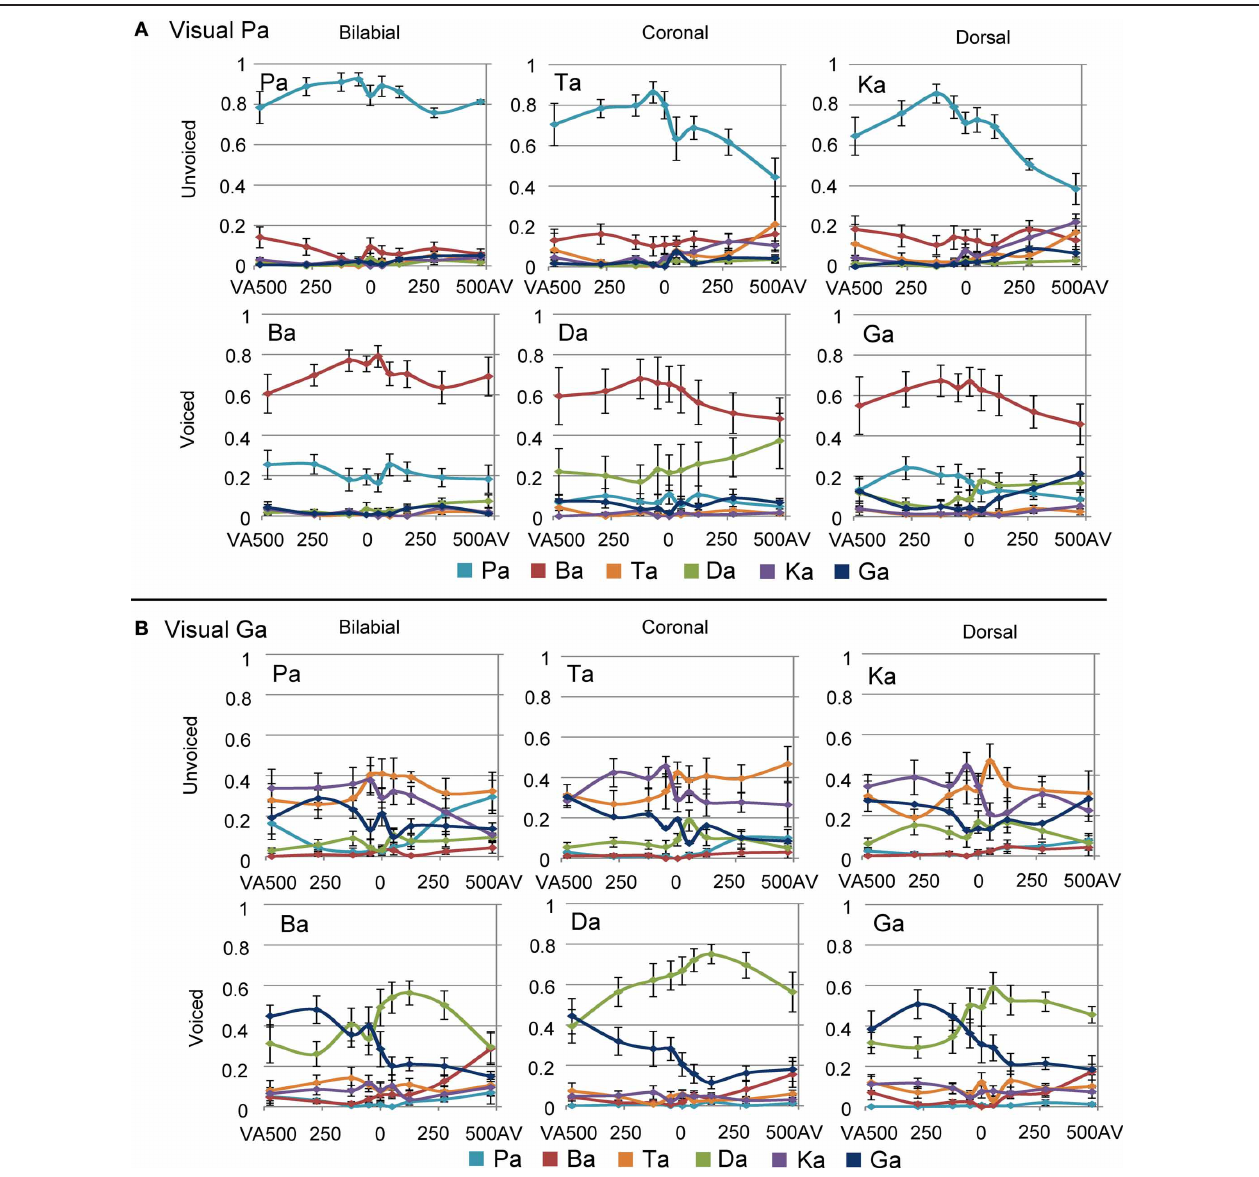
FIGURE 4 | Overall results of the multimodal experiment for visual /pa/ (A) and visual /ga/ (B), combined with the six auditory stimuli and all stimulus onset asynchronies (SOAs). Negative SOAs indicate that the visual stimulus was shifted to an earlier point in time compared to the auditory